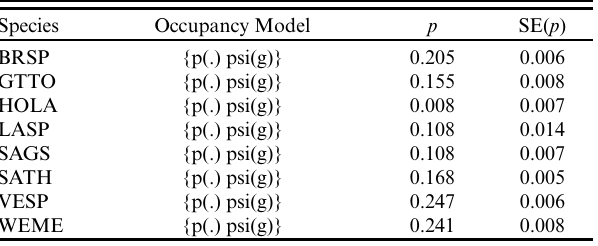
Table 2 . Occupancy model selected representing constant detection probability ( p (.)) occupancy varying by site and year (psi(g)), detection probability during a 1-minute interval ( p ),